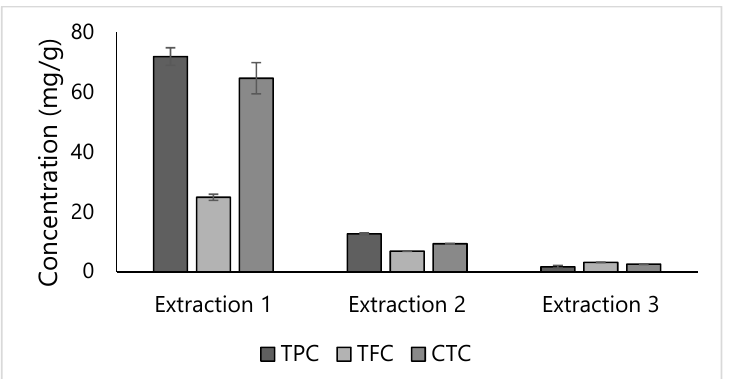
Figure 1. Total phenolic compounds (TPC), total flavonoid compounds (TFC), and total condensed tannins content (CTC) of lentil seed coat obtained using conventional solid–liquid three-time extraction draws of 15 h each with aqueous methanol (MeOH:H 2 O) as solvent.